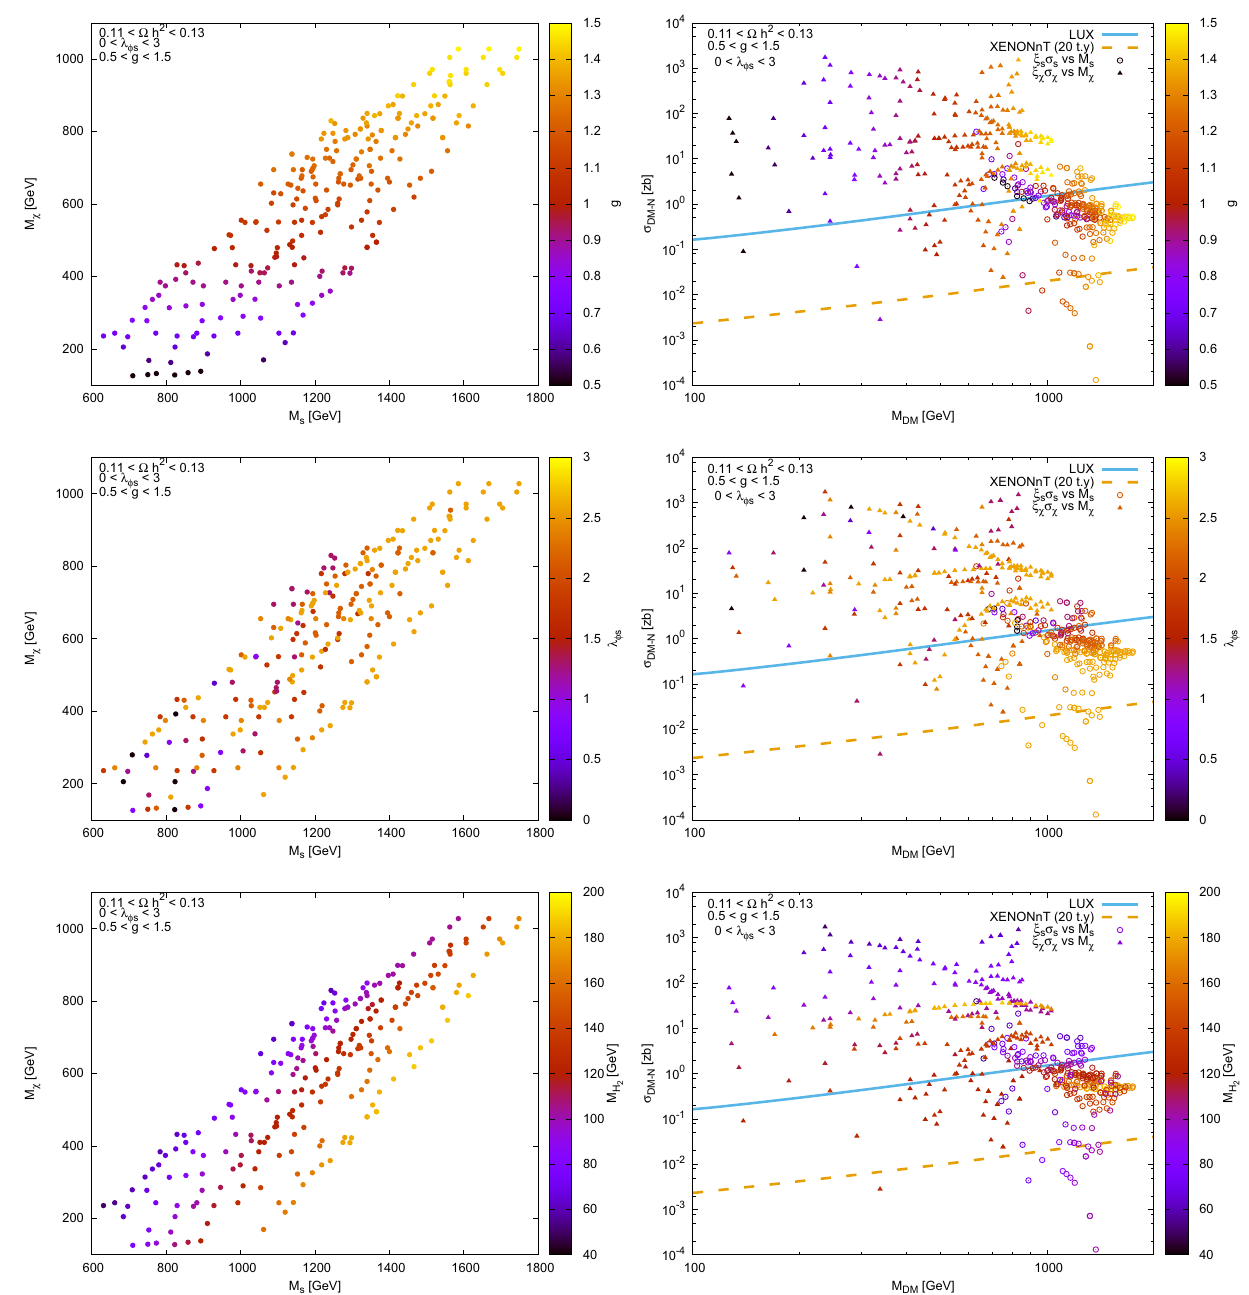
Fig. 7 (Left) Scatter points depict the ranges of the parameter space of the model in M s and M χ plane for different parameters of the model, which are consistent with the observed relic density by the Planck col- laboration [38]. (Right) Rescaled DM–nucleon cross section as a func-